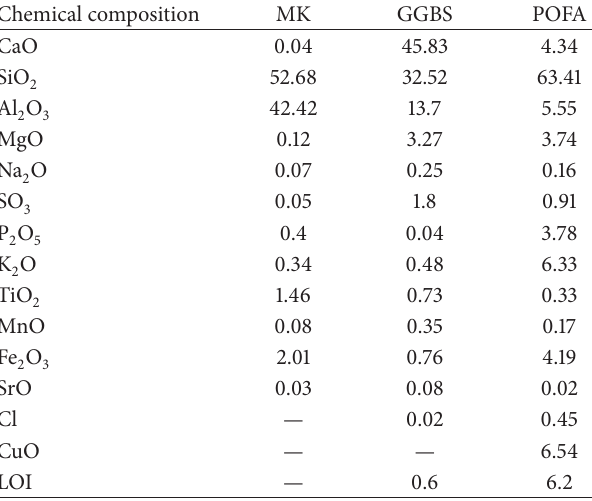
Table 1: The raw materials (MK, GGBS, and POFA) chemical com- position (wt %).